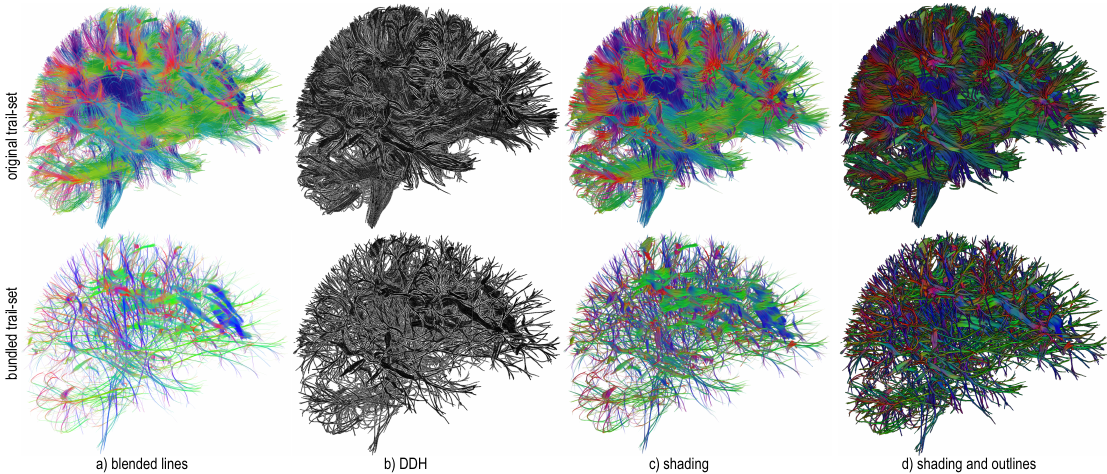
Figure 12. Comparing four rendering modes for a small 65 K trail set. Original unbundled data ( top row ) and its bundled counterpart ( bottom row ). See Section